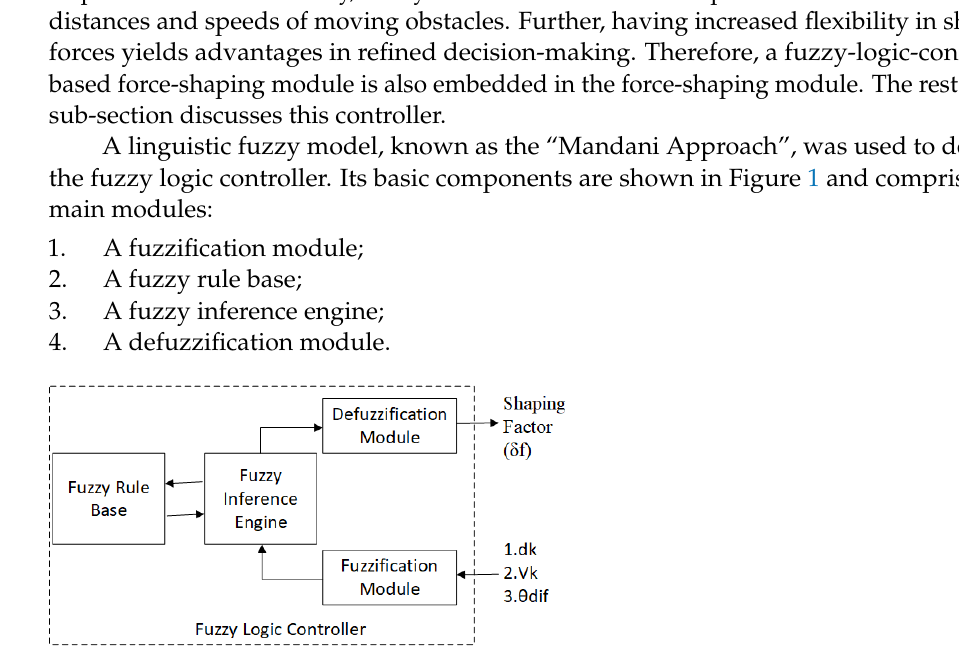
Figure 1. A block diagram of the fuzzy logic controller (FLC).